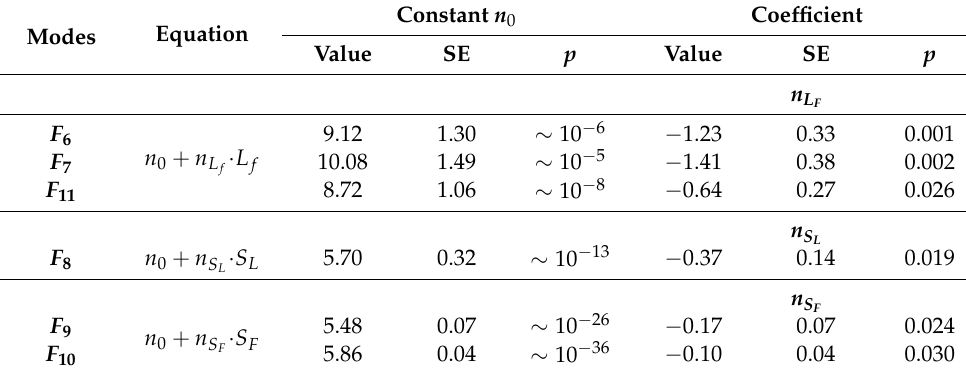
Table 6. Models for modes 6–11 and their coefficients of variables and